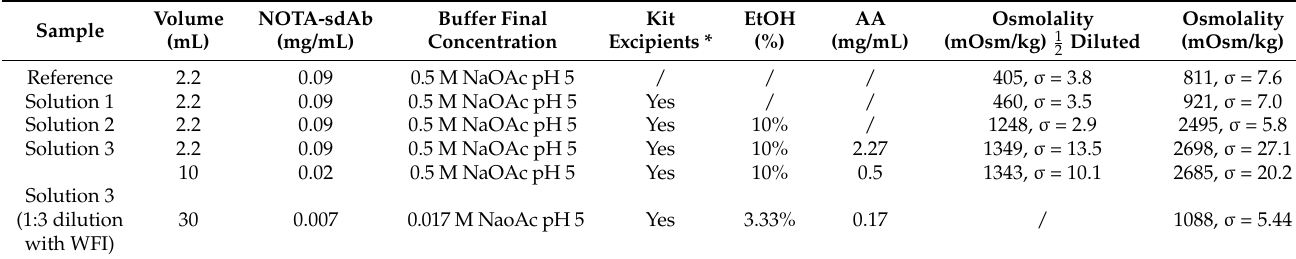
Table 7. Osmolality of different